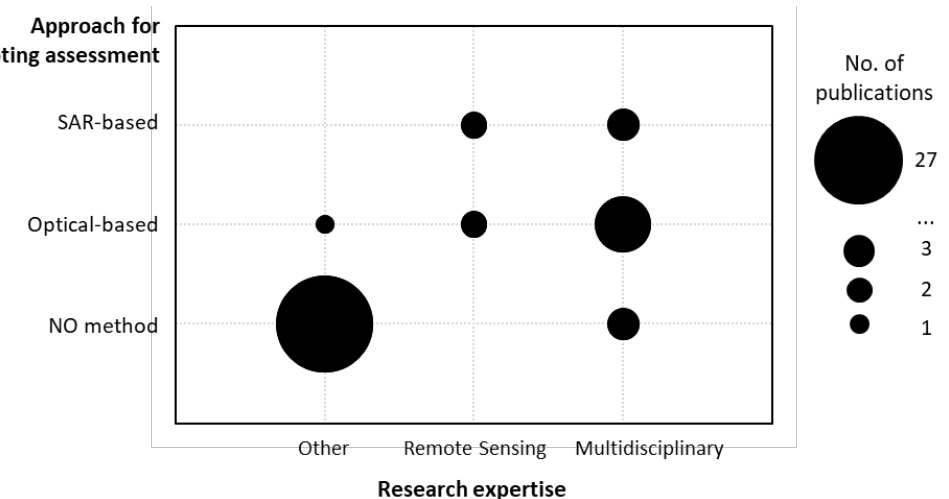
Figure 21. Comparison between the research expertise of authors using satellite images to assess looting (x axis) and the approach for looting assessment employed (y axis), i.e., an image processing-based method relying on either synthetic aperture radar (SAR) or optical data, or without the aid of any image processing (therefore, visual/manual methodologies).